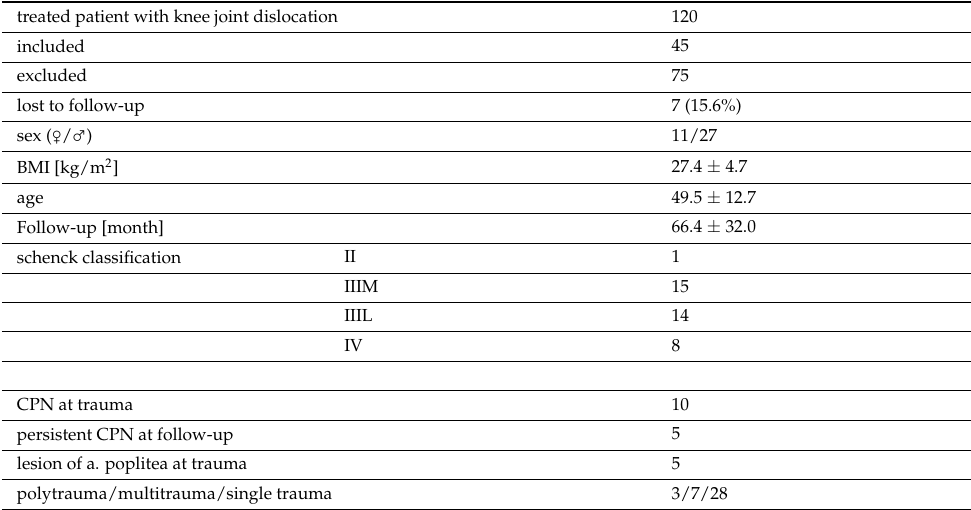
Table 1. Epidemiological information about the cases